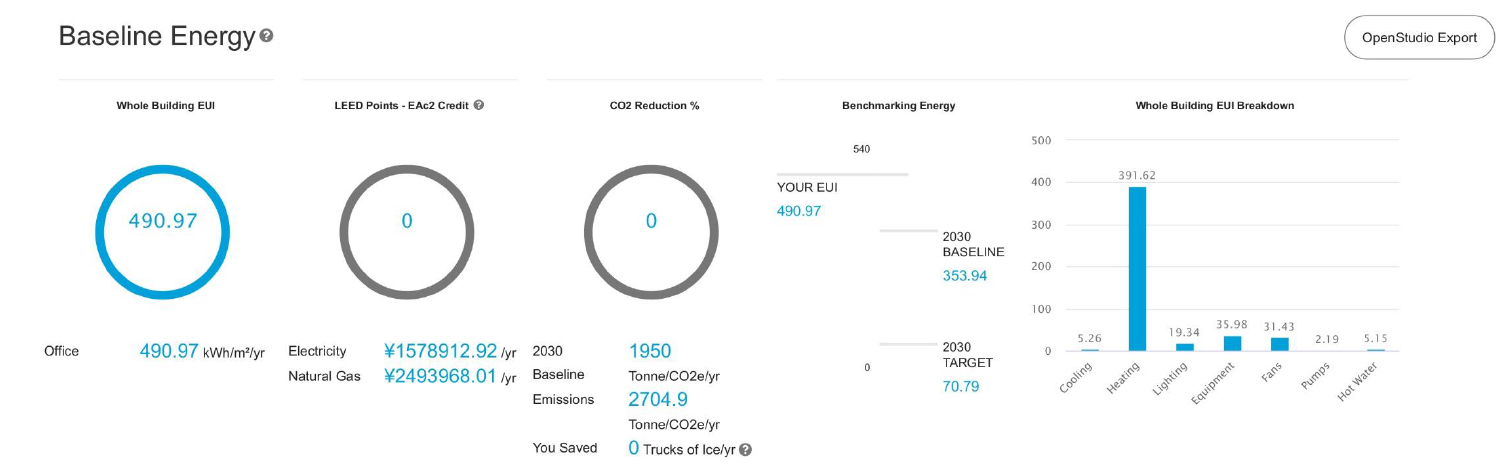
Figure A22. Zone 5-A Shenyang, Liaoning (pre-COVID-19 scenario).